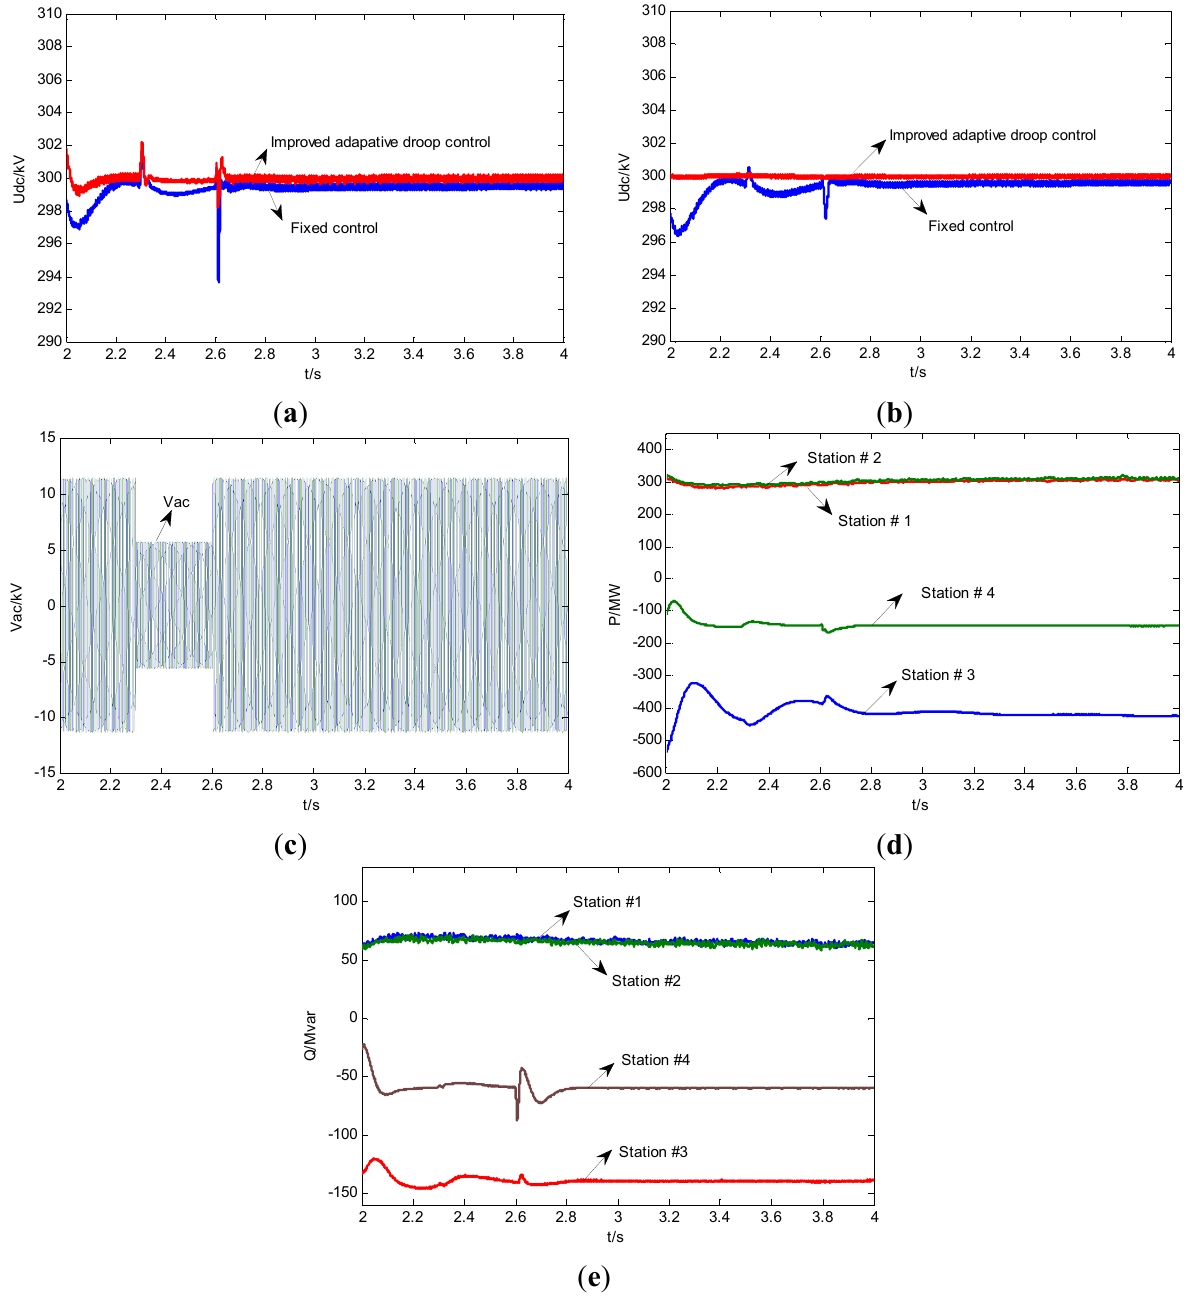
Figure 14. Dynamic response of short-circuit fault. ( a ) DC voltage of station # 4; ( b ) DC voltage of station # 3;( c ) AC side voltage of station # 4; ( d ) Active power of VSC-MTDC; ( e ) Reactive power of